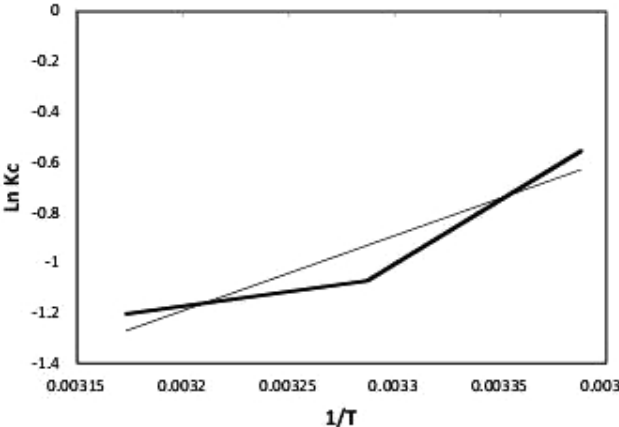
Fig. 3. Pseudo-second-order plots for the adsorption of CV + onto modified dolomite.